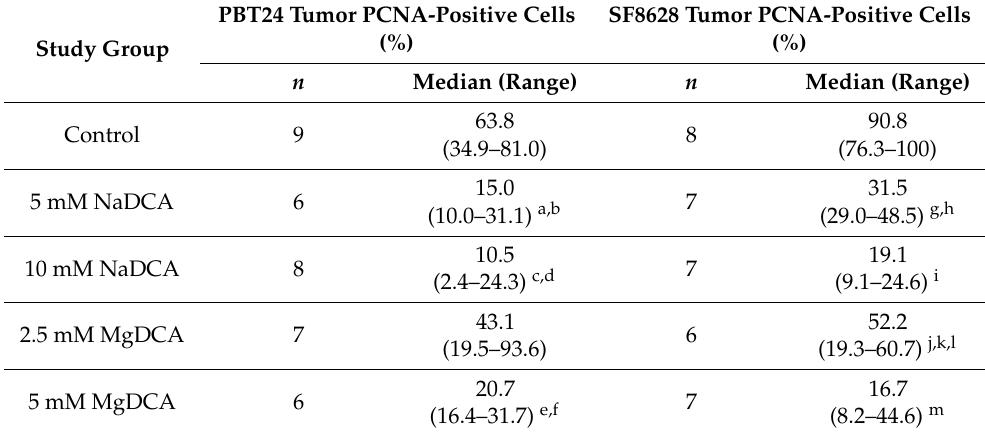
Table 2. The PCNA-positive cells percentage in PBT24 and SF8628